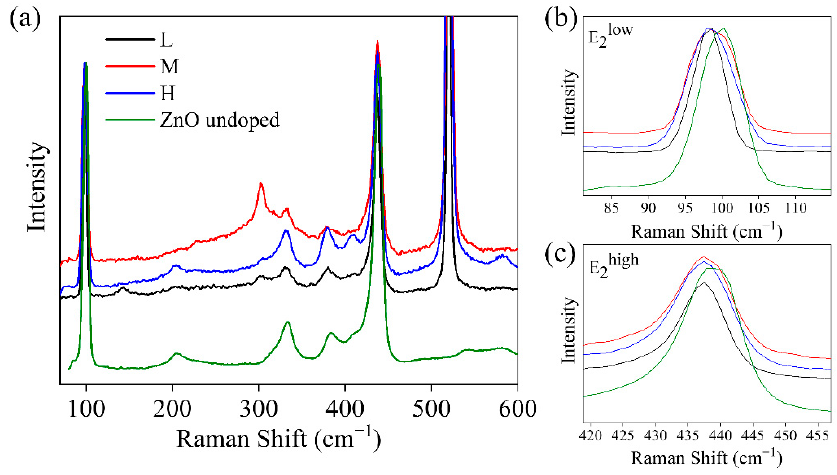
Figure 5. ( a ) Raman spectra of K-doped ZnO samples and undoped ZnO reference normalized to the peak of 98 cm − 1 . ( b , c ) Details of the peaks E 2low and E 2high , respectively. A small displacement is appreciated with respect to the reference. Table 1. Calculation of the FWHM of the peaks at 100 and 437 cm − 1 for each sample.